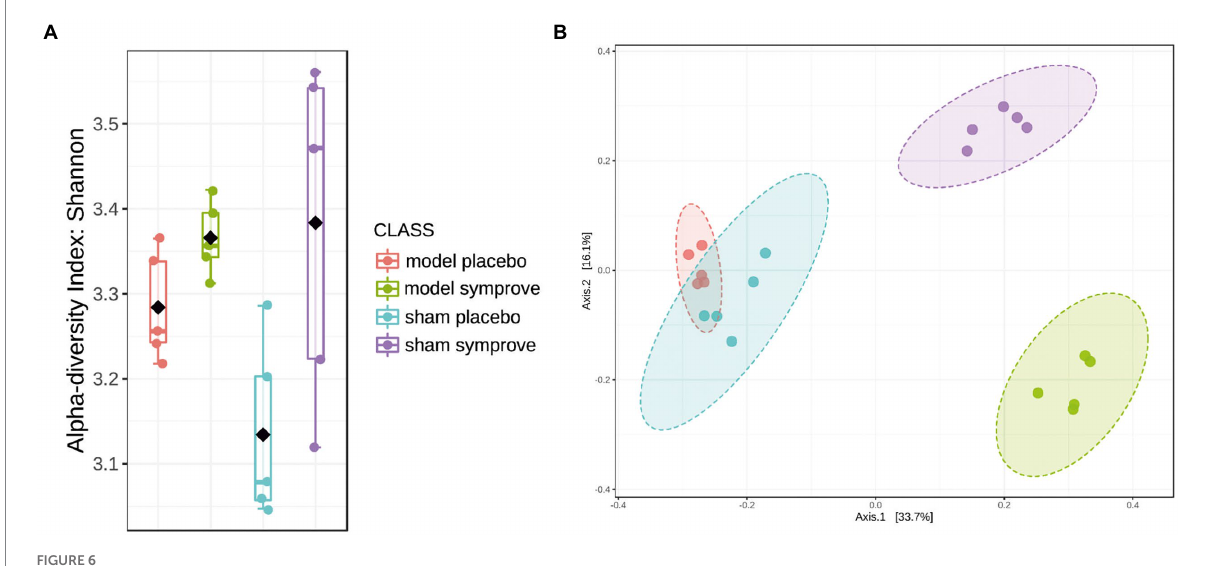
FIGURE 6 Effect of Symprove ™ on gut microbiota structure in all experimental groups (Sham + placebo, Sham + Symprove ™ , model + placebo and model + Symprove ™ , n = 5 in each group). (A) Alpha diversity performed using Shannon Index; Symprove ™ treatment was able to increase significantly, alpha diversity both in the sham and model groups. (B) Beta diversity was significantly different among all